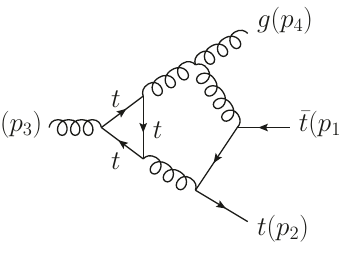
Figure 7. Feynman diagram contributing to A (2) ,N h that leads to the new master integral topolo- gies shown in figure 6. The solid lines denoted the top quark whereas spiral lines denote the gluons. All external momenta are